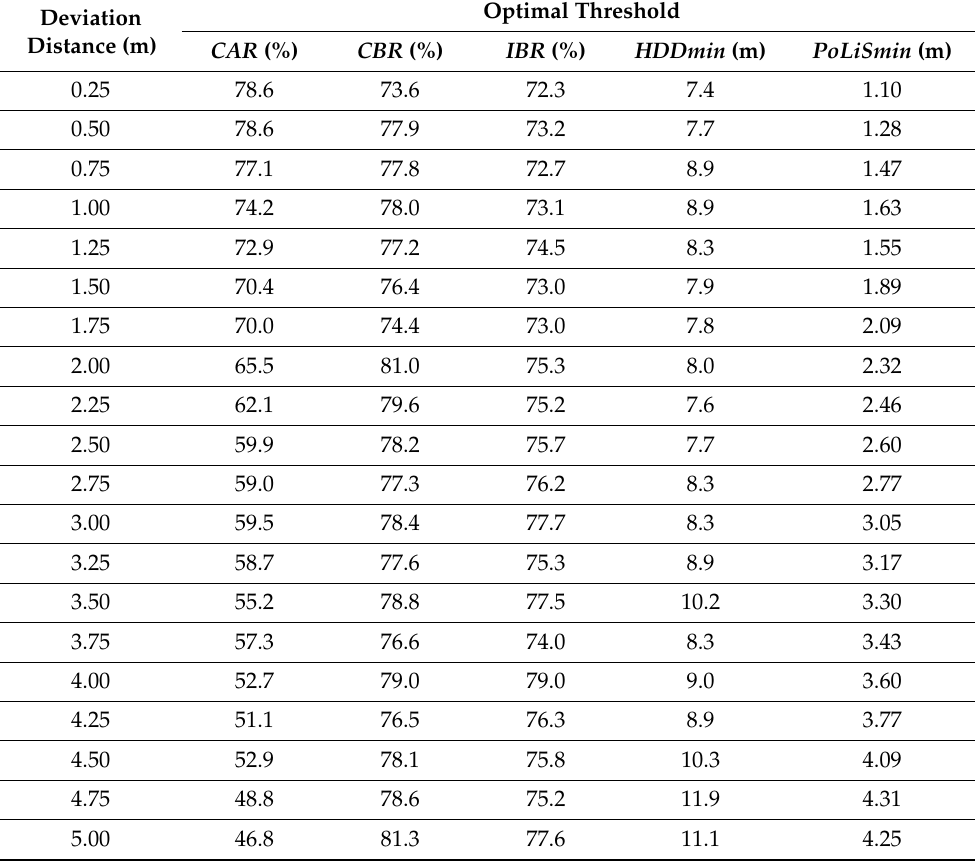
Table 3. Optimal thresholds per deviation distance of generated